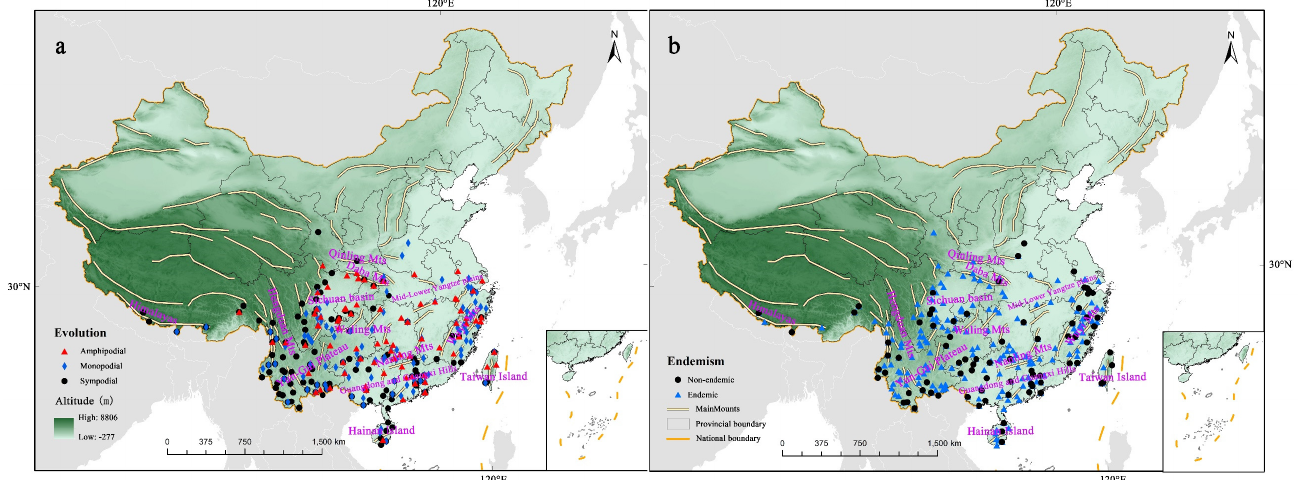
Figure 2. Distribution centers of bamboos. ( a ) Non-endemic bamboos; ( b ) Endemic bamboos. The longitude of non-endemic monopodial bamboos was significantly farther east than that of endemic monopodial bamboos, but the longitude of sympodial and amphipo- dial bamboos was not significantly different between different endemism types (Figure 3A). In terms of non-endemic bamboos, the longitude of the amphipodial bamboo was significantly farther west than that of monopodial bamboos, whereas it was significantly farther east than that of sympodial bamboos. Endemic sympodial bamboos located farther west in China, were significantly different from endemic amphipodial and monopodial bamboos. The latitude of non-endemic sympodial bamboos was significantly lower than that of endemic sympodial bamboos, but the latitude of non-endemic monopodial bam- boos was significantly higher than that of endemic monopodial bamboos (Figure 3B). The latitude of sympodial bamboos was lower than that of amphipodial and monopodial bam- boos, but there was no significant difference between amphipodial and monopodial bam- boos, regardless of endemism types. Additionally, the interaction between rhizome types and endemism had significant effects on longitude and latitude ( p < 0.05). Figure 3. Variations of the longitude and latitude between different endemism and among different rhizome types. Boxes with different letters differ significantly at p < 0.05. The lowercase letters mean